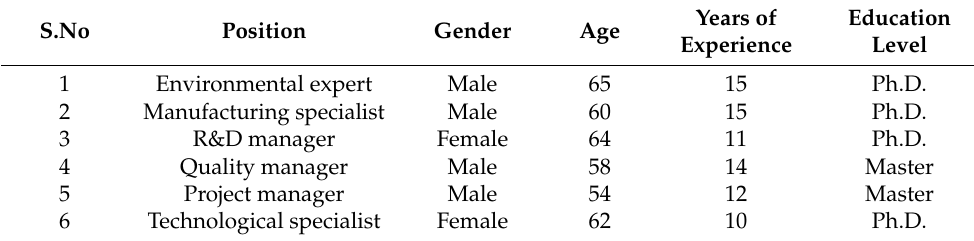
Table 2. Demographics characteristics of